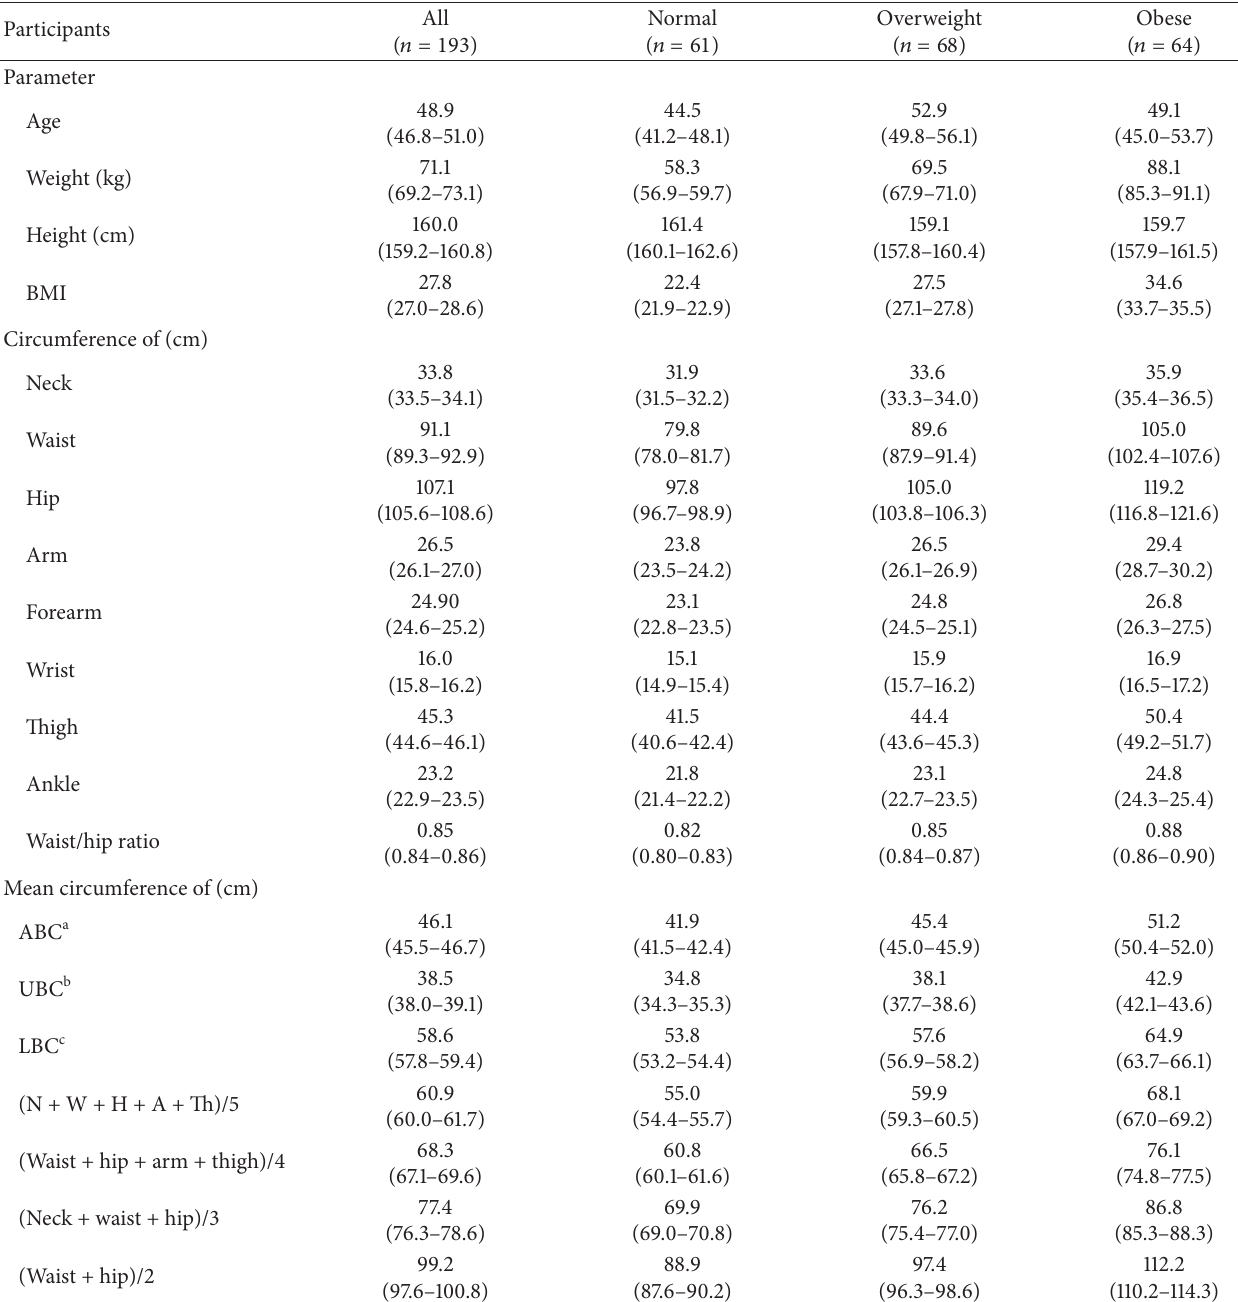
Table 1: Anthropometric parameters of the study